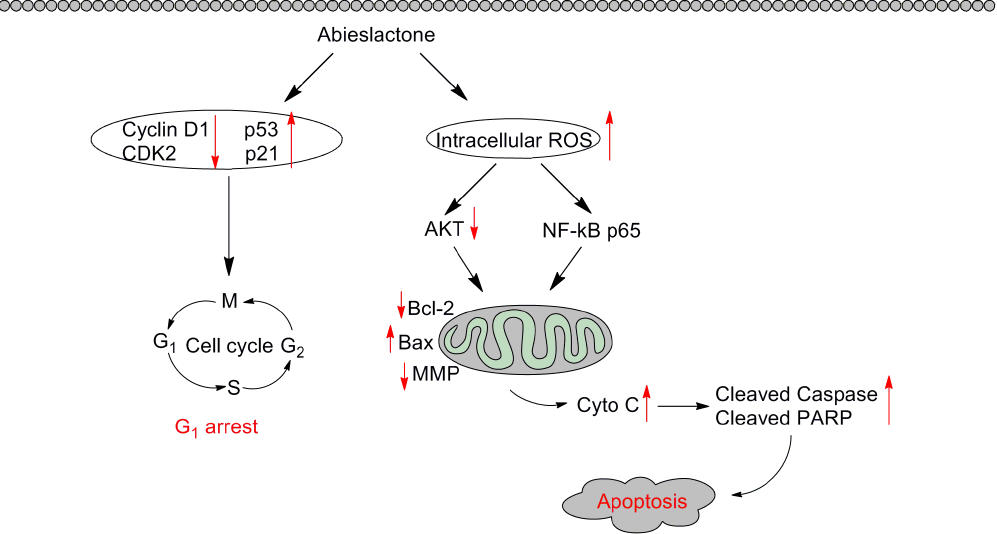
Fig. 8. Schematic form of the proposed mechanisms for abieslactone-induced G 1 arrest and apoptosis in HepG2